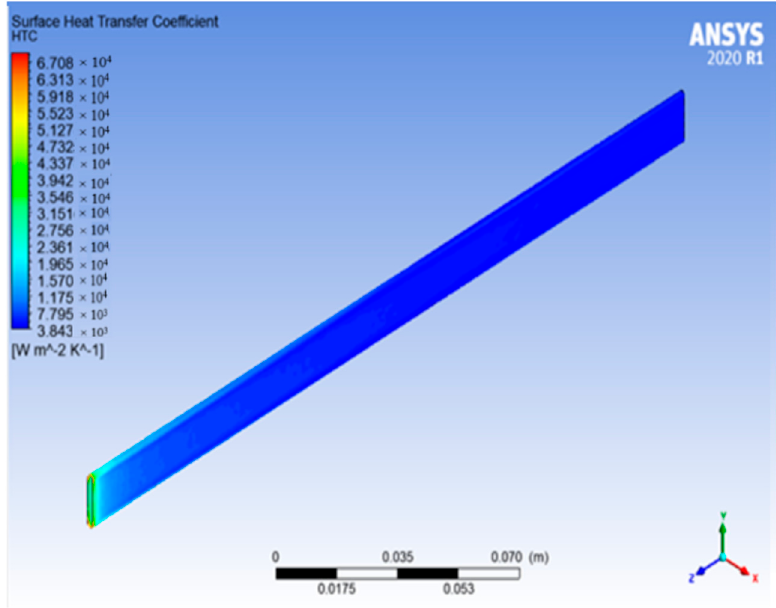
Figure 22. The pipe simulation at optimized size with G + CNC (0.01%).